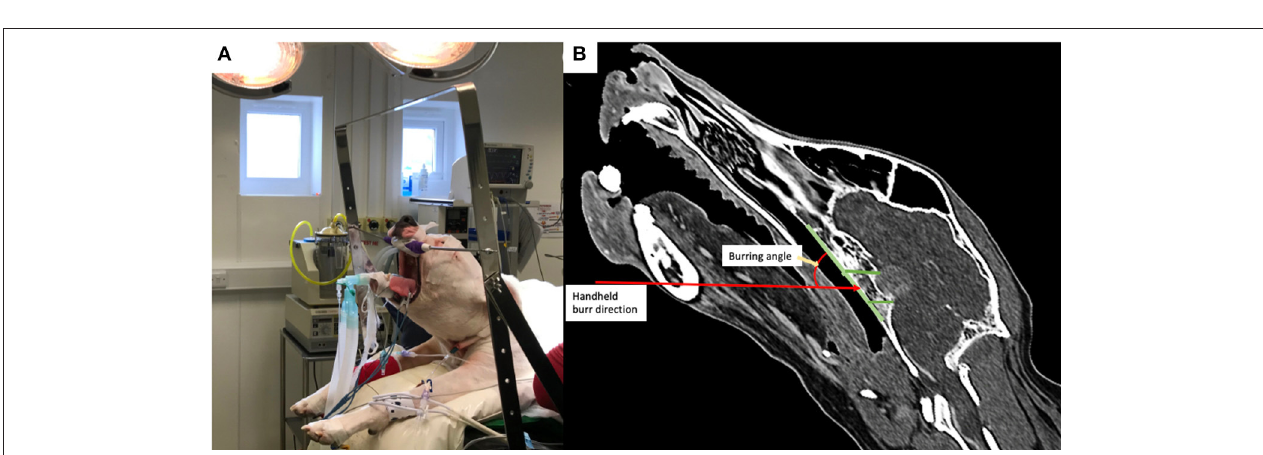
FIGURE 2 | (A) Photograph of a dog positioned in theatre with the head attached by the canine teeth to a metallic bar; note the head is therefore tilted from horizontal; (B) post-operative reconstructed sagittal CT image in a bone window showing the angulation required for burring with the handheld drill into the basisphenoid